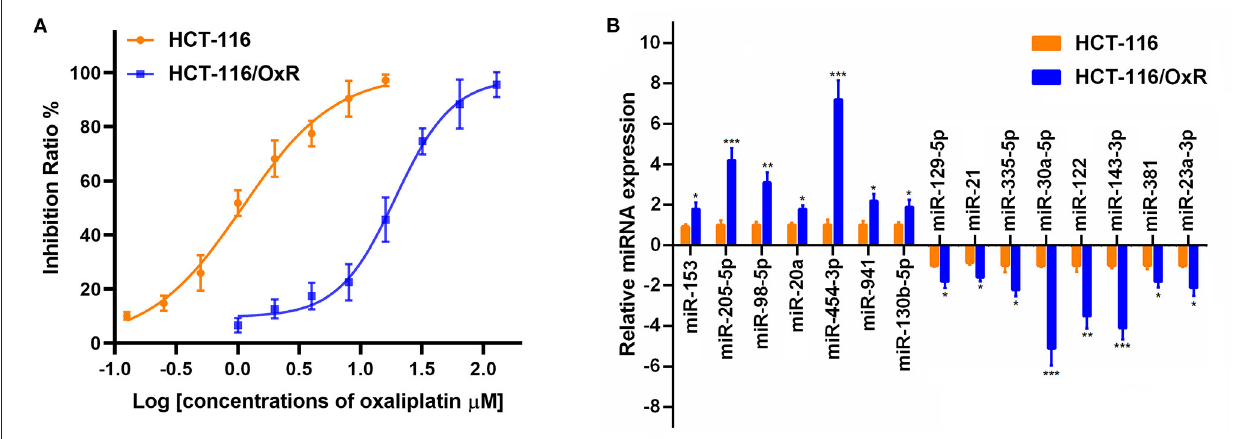
FIGURE 1 | The expression of miRNAs in oxaliplatin-sensitive and -resistant HCT-116 colorectal cancer cells. (A) Effects of oxaliplatin on cell viability analyzed using MTT assay in HCT-116 and HCT-116/OxR cells. (B) Quantitative RT-PCR analysis on the expression of a panel of miRNAs between HCT-116 and HCT-116/OxR cells. U6 small nuclear RNA was used as an internal control. Results were presented as mean ± SD from three independent experiments. * P < 0.05, ** P < 0.01, *** P <